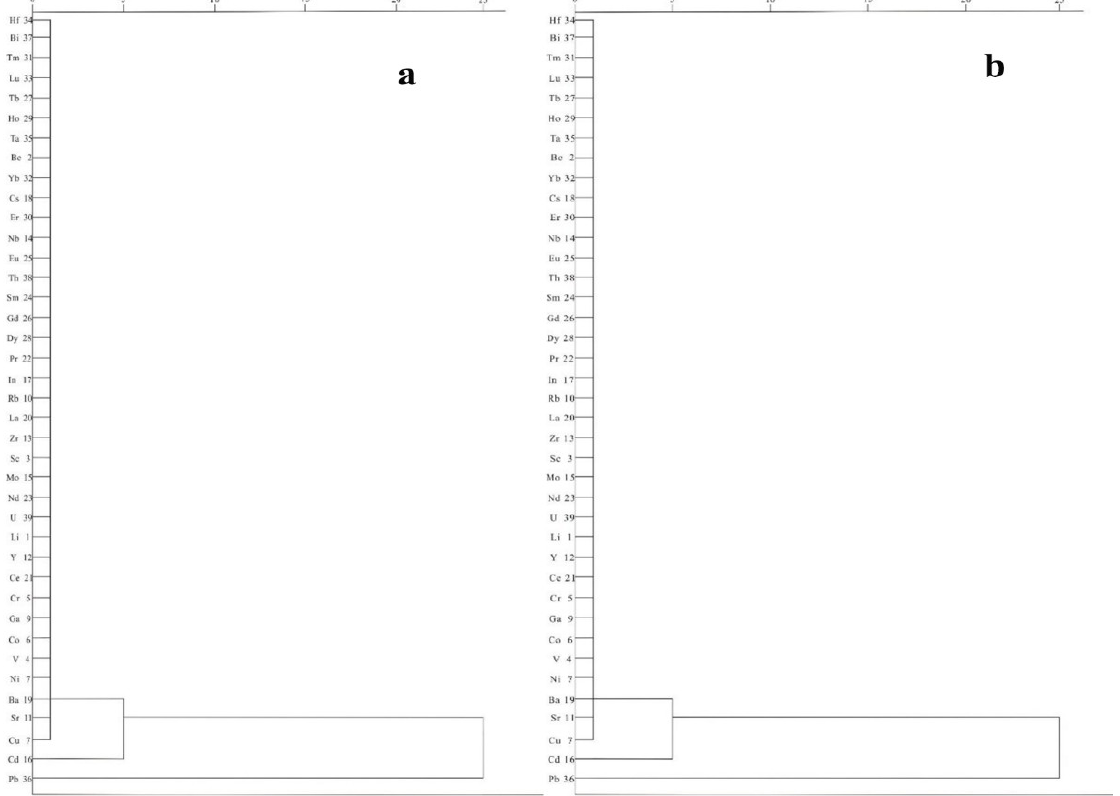
Figure 5. Pedigree diagram of element clustering in samples B ( a ) and B 1 ( b ) .